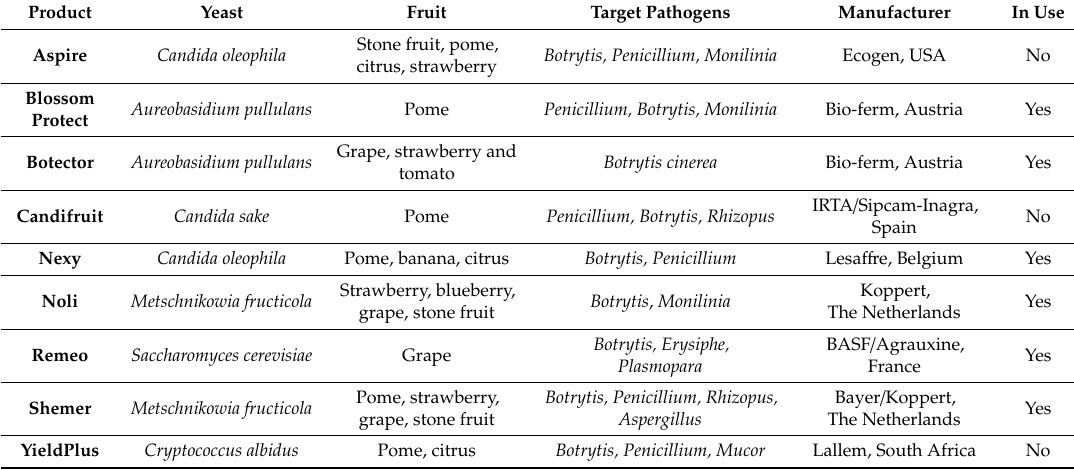
Table 1. Antagonistic yeast-based commercial products developed for the management of postharvest pathogens (adapted from [9] and [115] with